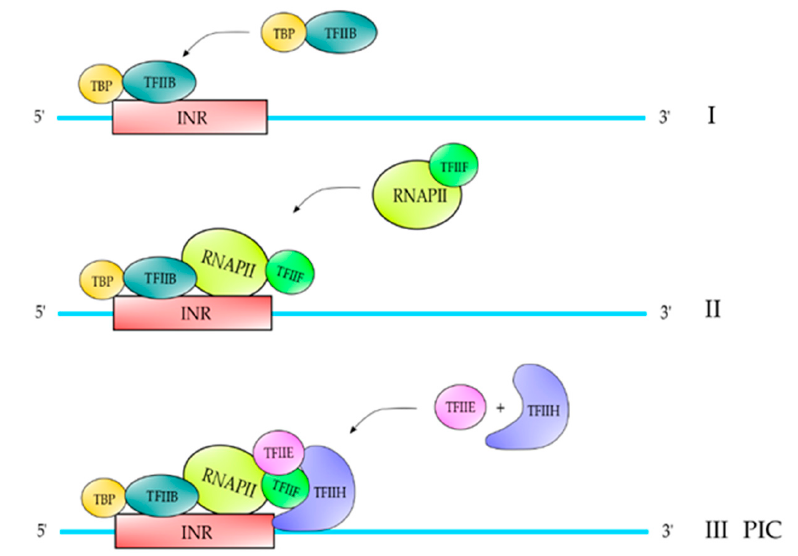
Figure 3. PIC formation on an INR-containing promoter. In those promoters that contain an INR, the complex TBP-TFIIB binds to this element (I) and after the complex RNAPII-TFIIF enters the complex (II), which follows the binding of TFIIE and TFIIH to complete the PIC formation (III). This model of PIC formation has not been published yet, but we have determined this pathway using pure RNAPII and recombinant factors from fission yeast and the nmt1 promoter in which the TATA box was